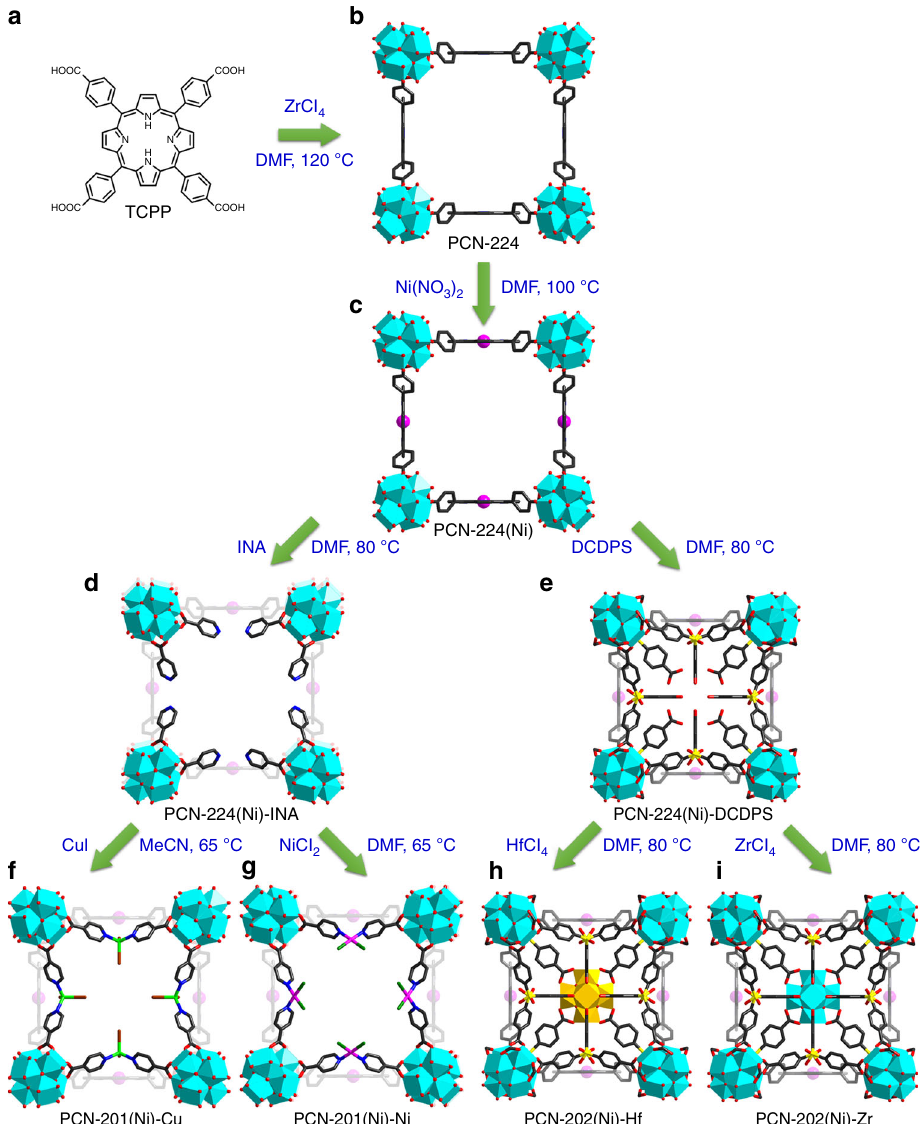
Fig. 3 Synthetic approaches to multi-component MOFs. a TCPP linker, b PCN-224, c PCN-224(Ni), d PCN-224(Ni)-INA, e PCN-224(Ni)-DCDPS, f PCN- 201(Ni)-Cu, g PCN-201(Ni)-Ni, h PCN-202(Ni)-Hf, and i